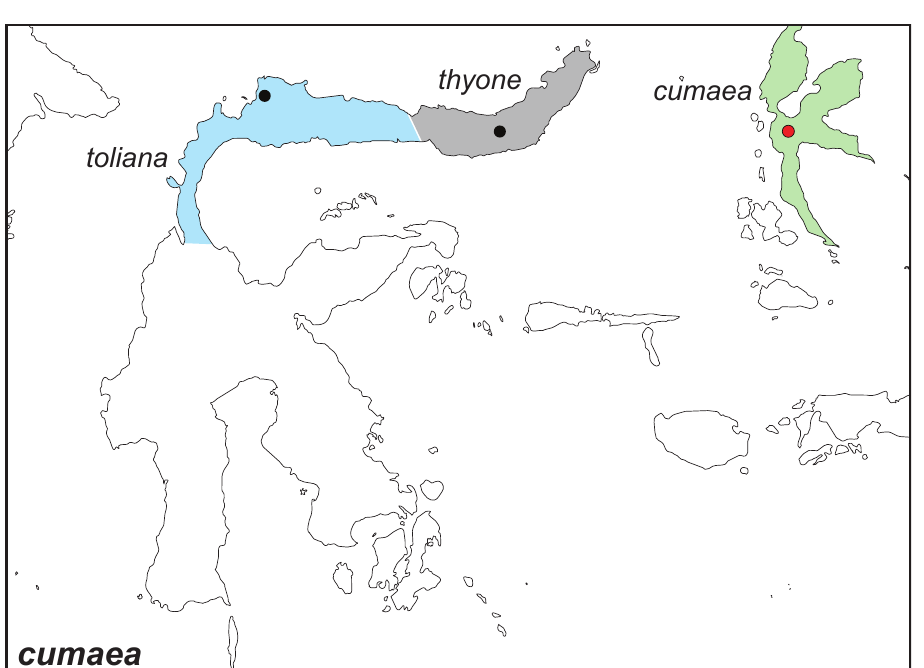
Figure 67. Distribution map of Elymnias cybele .